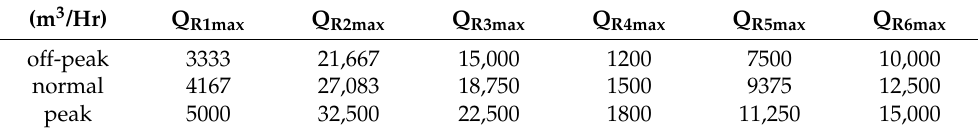
Table 5. Maximum water discharge during off-peak, normal, and peak periods for each WTP. (m 3